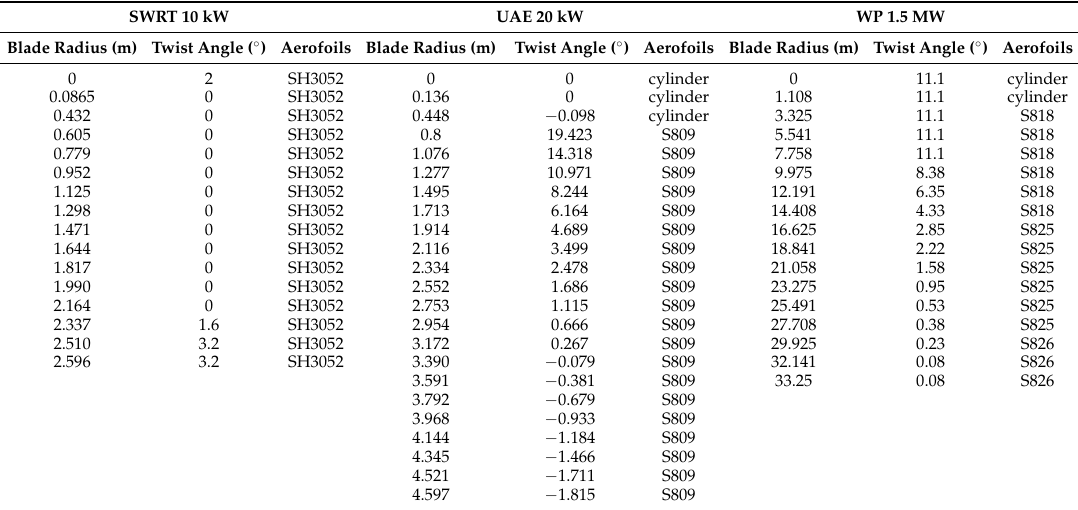
Table A1. Aerofoil distribution and twist angle of untwisted, stall-regulated, pitch-regulated blades. SWRT 10 kW UAE 20 kW WP 1.5